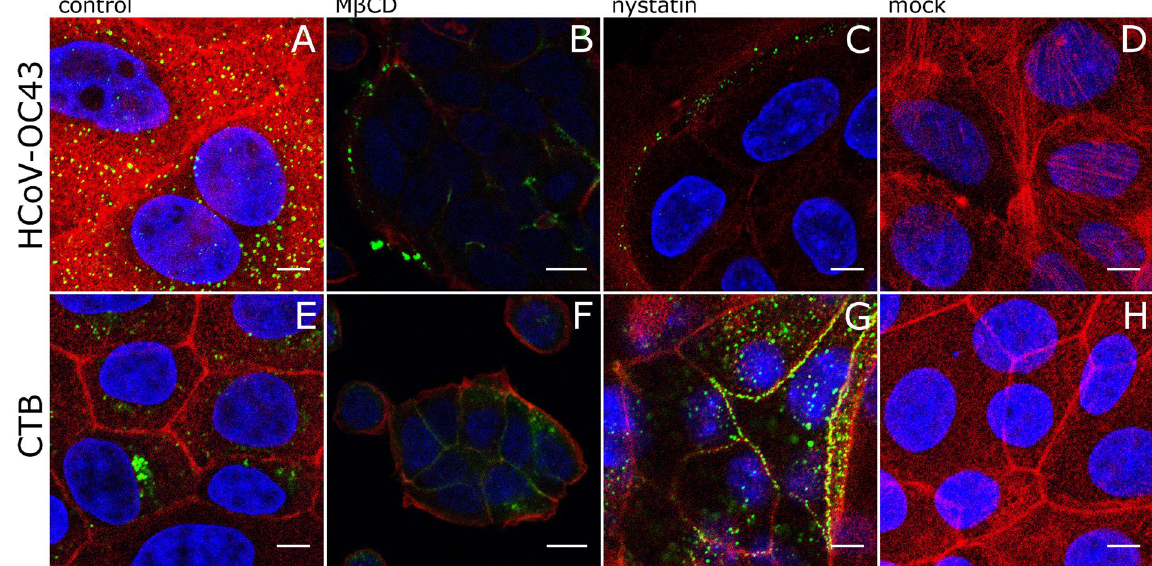
Figure 4. Disruption of caveolae with M β CD and nystatin hampers HCoV-OC43 entry. Confocal analysis of HCoV-OC43 or cholera toxin (CTB) entry to HCT-8 cells in the presence of cholesterol-sequestring agents was conducted. Following 1 h pretreatment with nystatin (100 μ g/ml) or M β CD (100 μ M), the cells were infected with HCoV-OC43 or overlaid with FITC-conjugated CTB (green). Actin cytoskeleton was stained to show the cell boundaries (red). Nuclei are shown in blue. ( A ) HCoV-OC43-infected inhibitor-untreated cells; ( B ) HCoV-OC43-infected M β CD-treated cells; ( C ) HCoV-OC43-infected nystatin-treated cells; ( D ) mock infected, inhibitor-untreated cells; ( E ) CTB inoculated, inhibitor-untreated cells; ( F ) CTB inoculated, M β CD-treated cells; ( G ) CTB inoculated, nystatin-treated cells; ( H ) mock inoculated, inhibitor-untreated cells. mock – mock inoculated cells; control – HCoV-OC43/CTB inoculated cells, in the absence of inhibitors. Scale bar = 10 μ m. The experiment was conducted at least thrice and representative images are